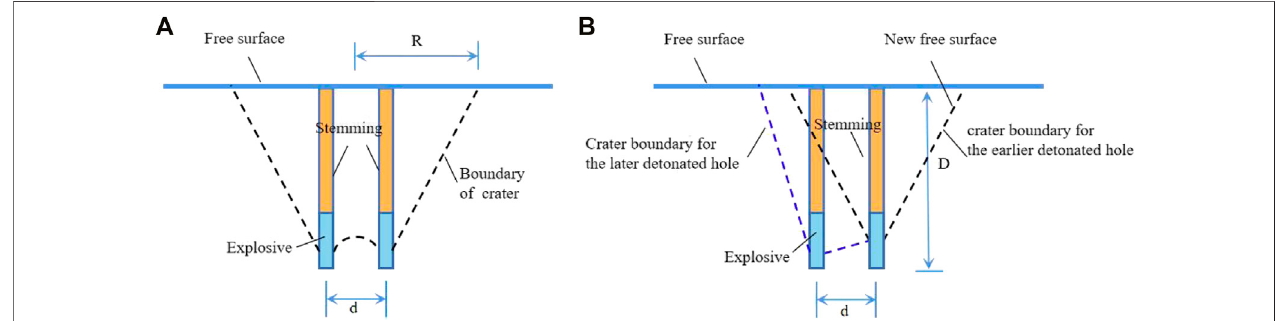
FIGURE 15 | (A) Simultaneous initiation of multiple blast holes. (B) Multiple blast holes with delayed initiation (Qiu et al., 2018).